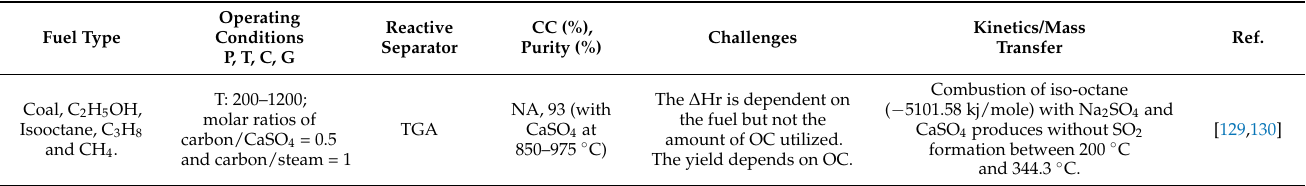
Table 5. An overview of chemical looping combustion-based carbon